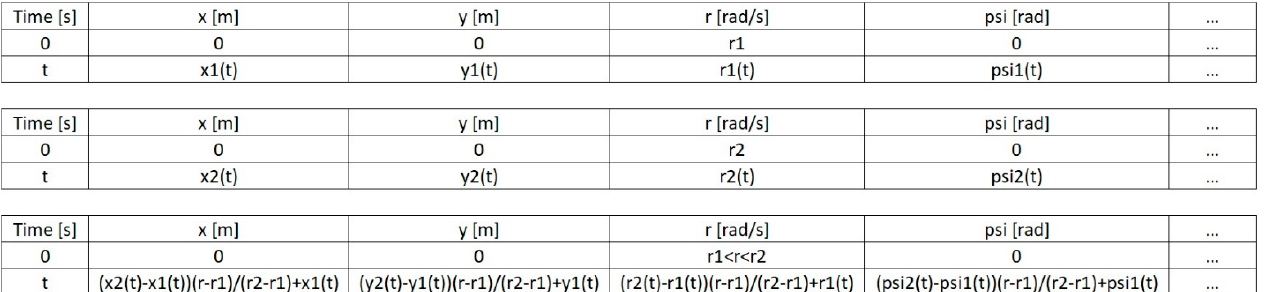
Figure 3. The method of determining (using linear interpolation) an example row of the table for the starting conditions corresponding to an intermediate value of angular speed r when the tables are given for the starting conditions corresponding to the angular speed values of r 1 and r 2 ( r 1 < r < r 2 ) .